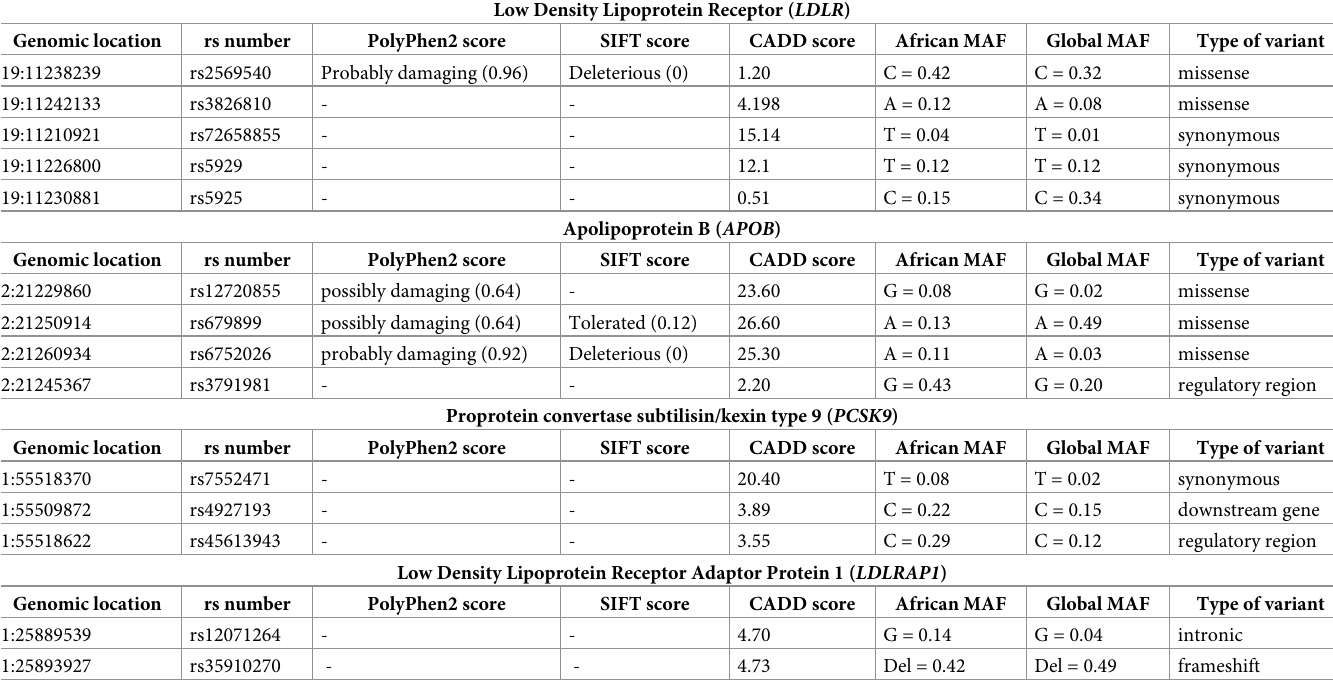
Table 2. Functional annotation scores and minor allele frequencies for 14 SNP